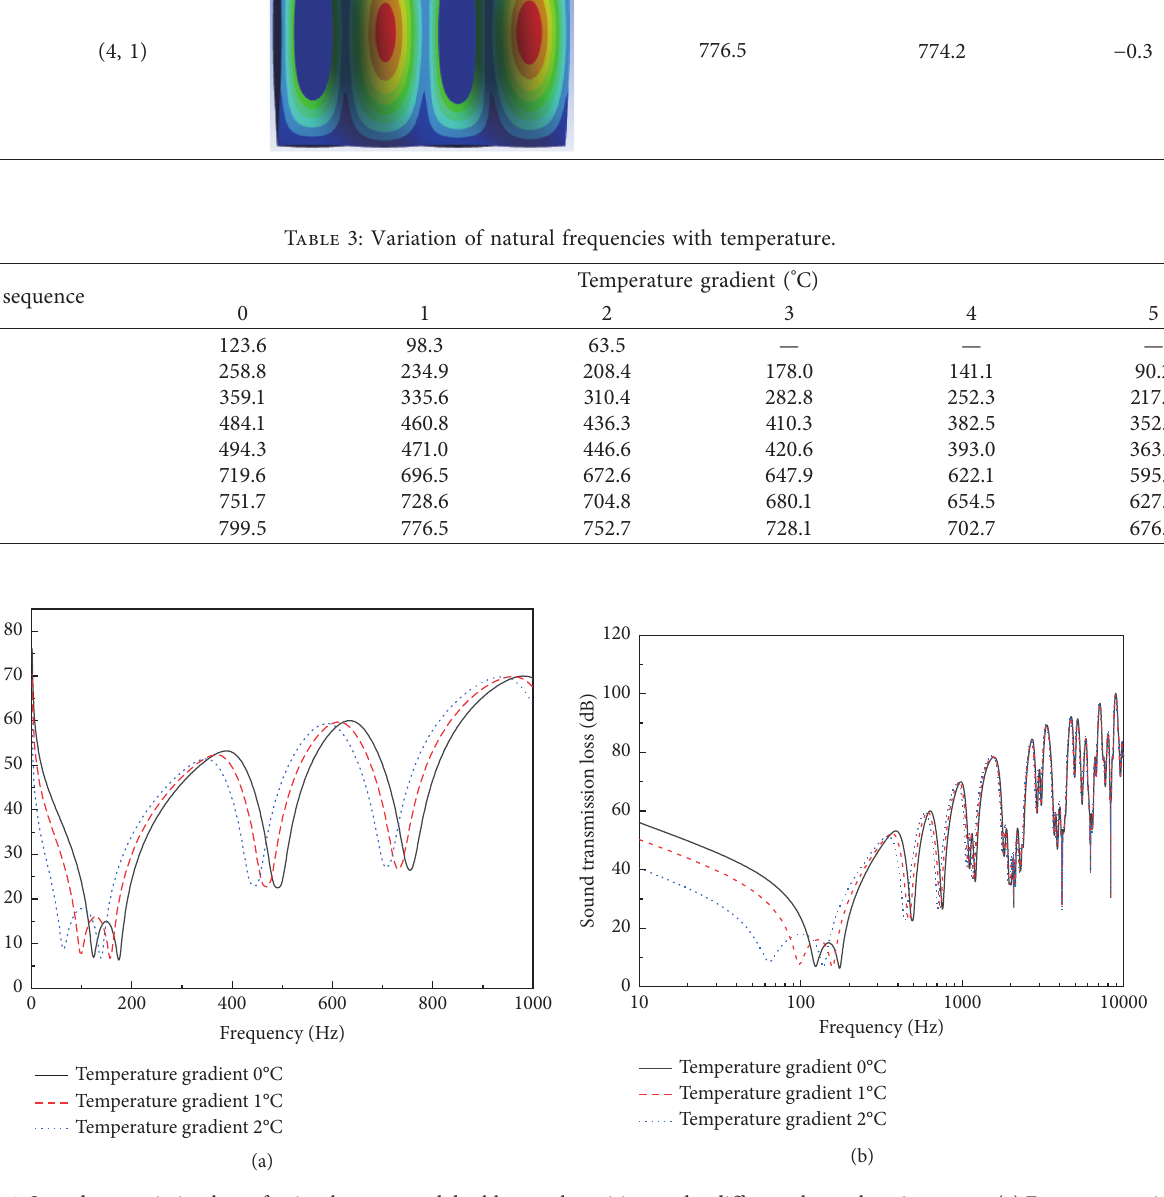
Figure 4: Sound transmission loss of a simply supported double-panel partition under different thermal environment. (a) Frequency region 0 ∼ 1000Hz. (b) Frequency region 0 ∼